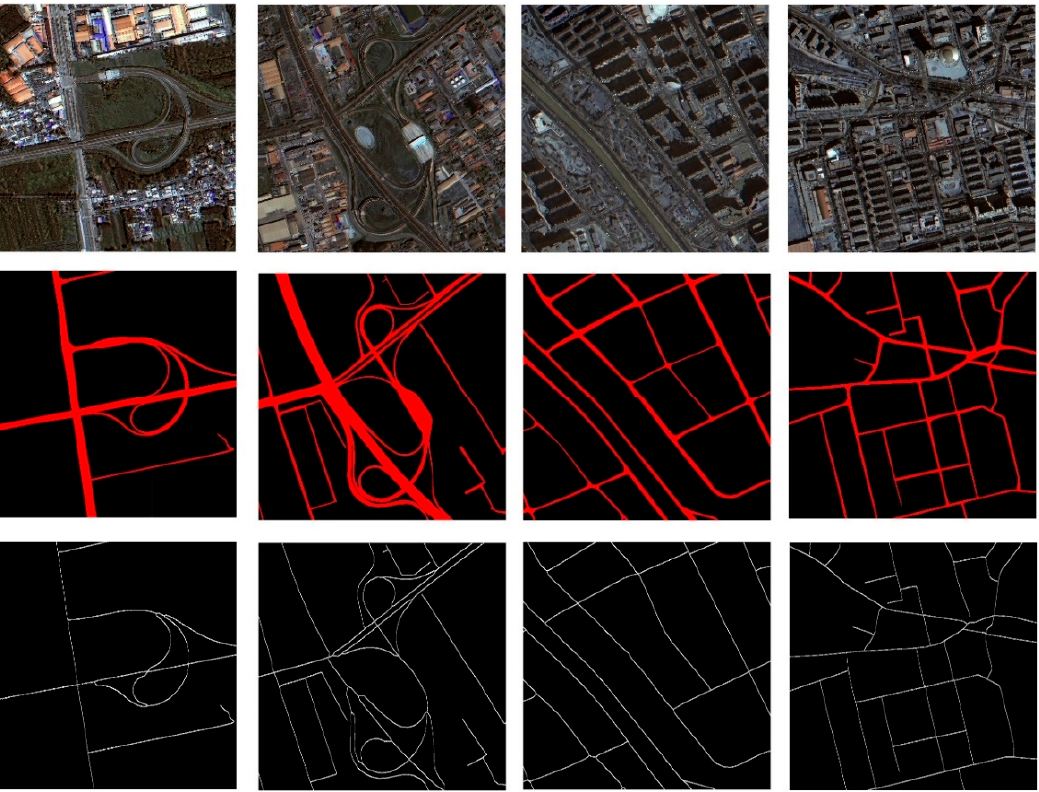
Figure 1. Representative images in our dataset.